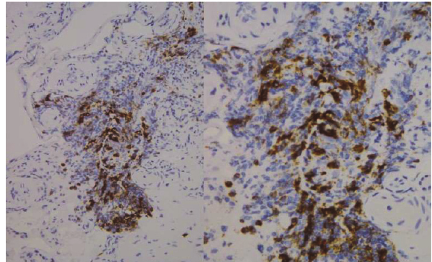
Figure 4: Immunohistochemistry/CD20 stain of brain biopsy (day 50). CD20+ perivascular B-cell infiltrates. Many also are staining positive for EBV-encoded RNA (EBER), which is not depicted but indicates presence of Epstein-Barr Virus. Additional stains of the and